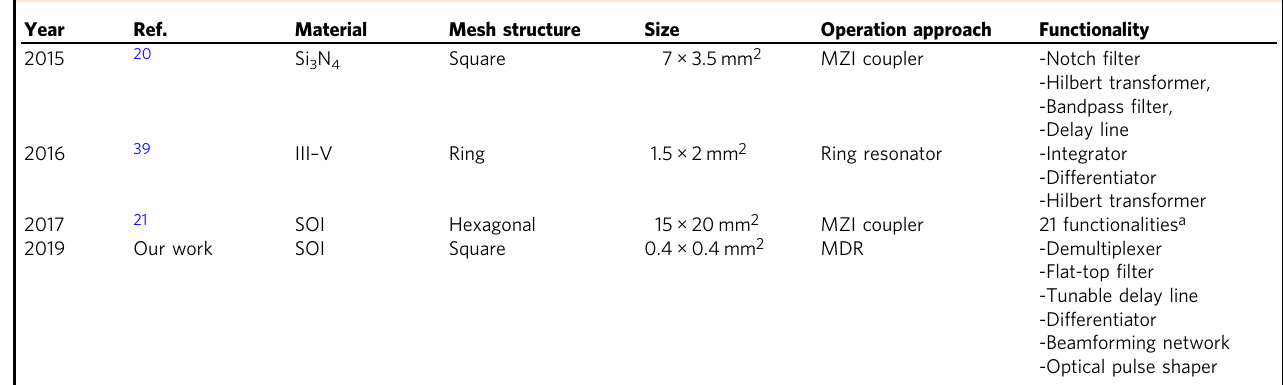
Table 1 Comparison of reported programmable optical signal processor.